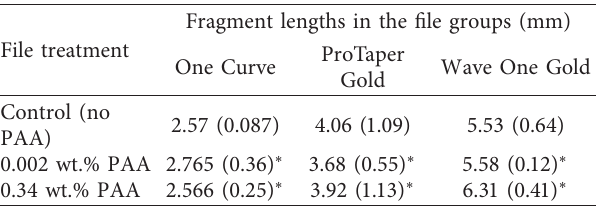
Table 4: The means and standard deviations (SD) of the frag- mented lengths of the tested files.